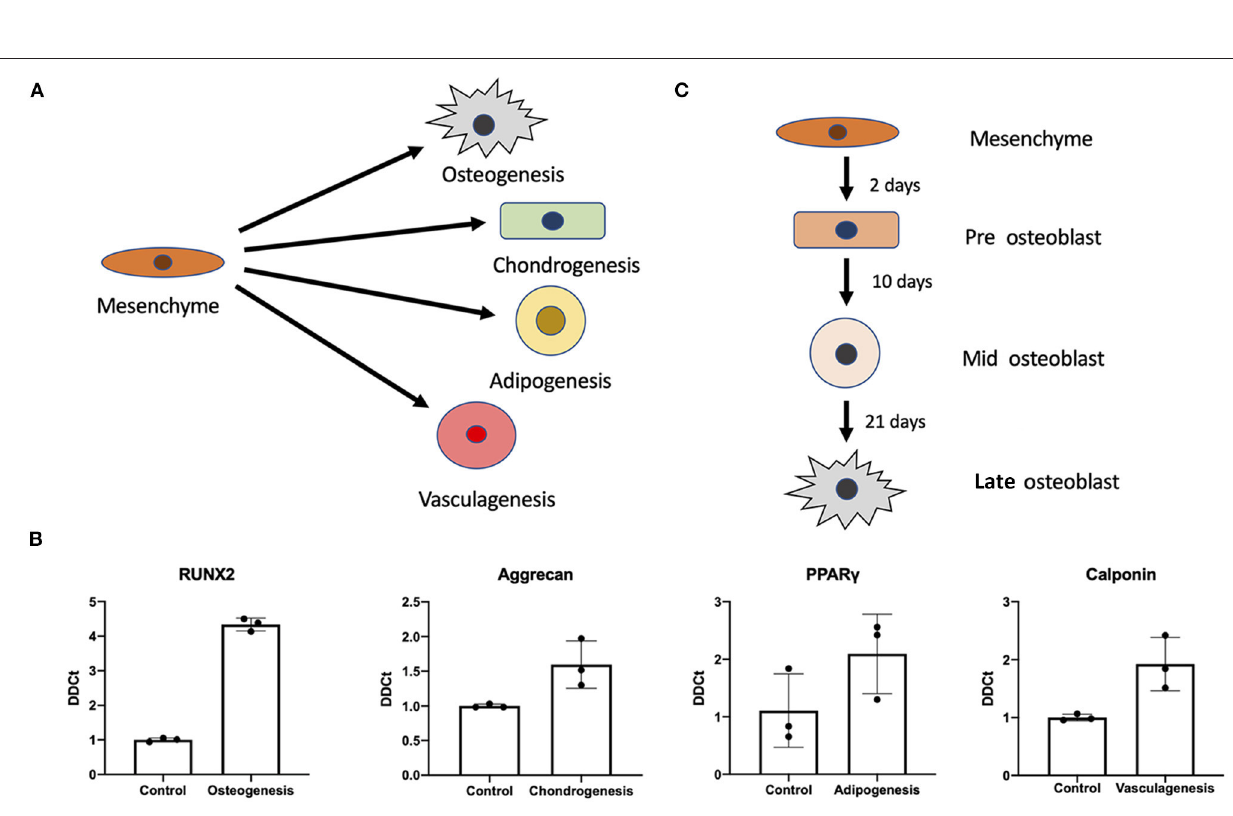
Frontiers in Cell and Developmental Biology |